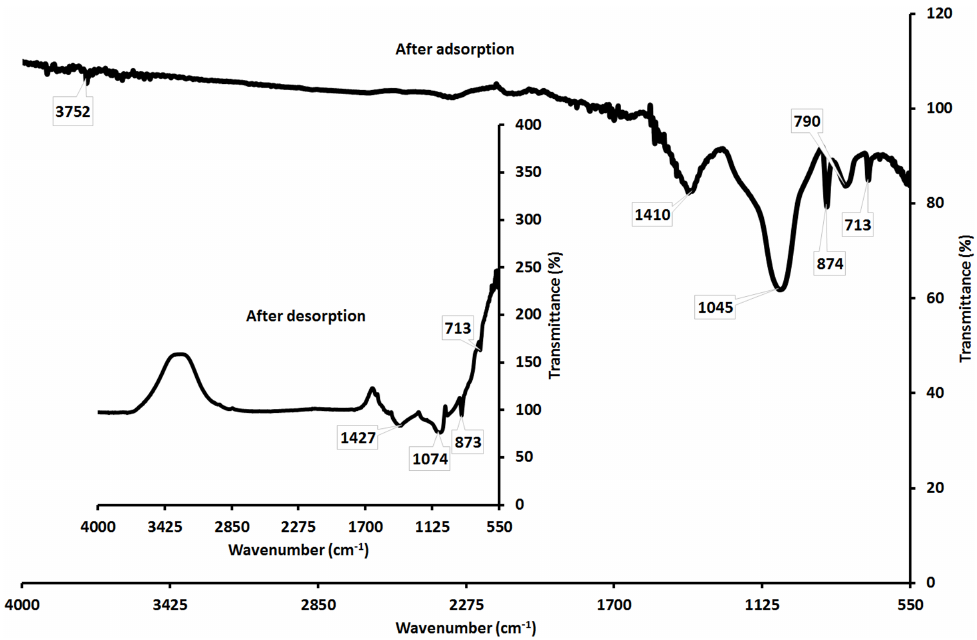
Figure 7 Showing the FTIR of CS – SiO 2 /CaCO 3 nanocomposite after adsorption of phenol and after desorption of